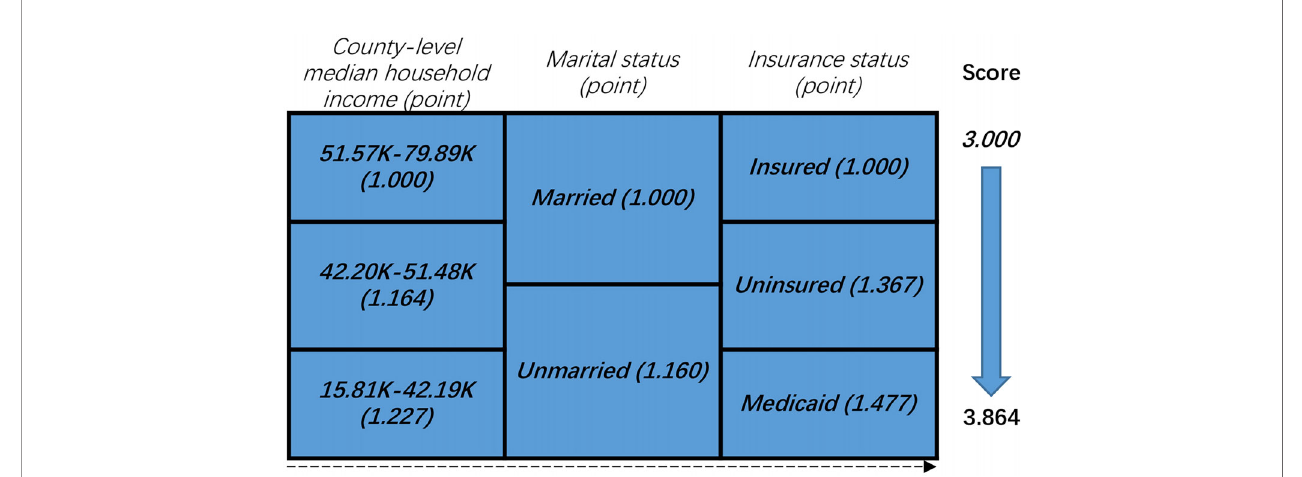
FIGURE 2 | Non-biological factor (NBF) score in colorectal cancer patients younger than 45 years: risk-strati fi